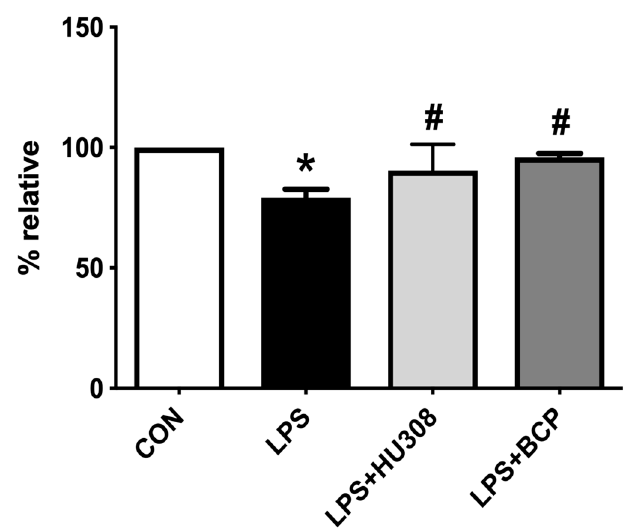
Figure 4. Capillary perfusion quantified through functional capillary density (FCD) within the bladder microcirculation of female CD-1 mice for the following experimental groups: control (CON; n = 9), lipopolysaccharide (LPS)-induced IC (LPS; n = 9), LPS-induced IC treated with HU308 (5 mg / kg, LPS + HU308; n = 4), LPS-induced IC treated with BCP (100 mg / kg, LPS + BCP; n = 7). Saline, LPS, BCP, and HU308 were all administered via intraperitoneal injection. Data are presented as percentage relative to the control group. * p < 0.05 vs. CON. # p < 0.05 vs. LPS.